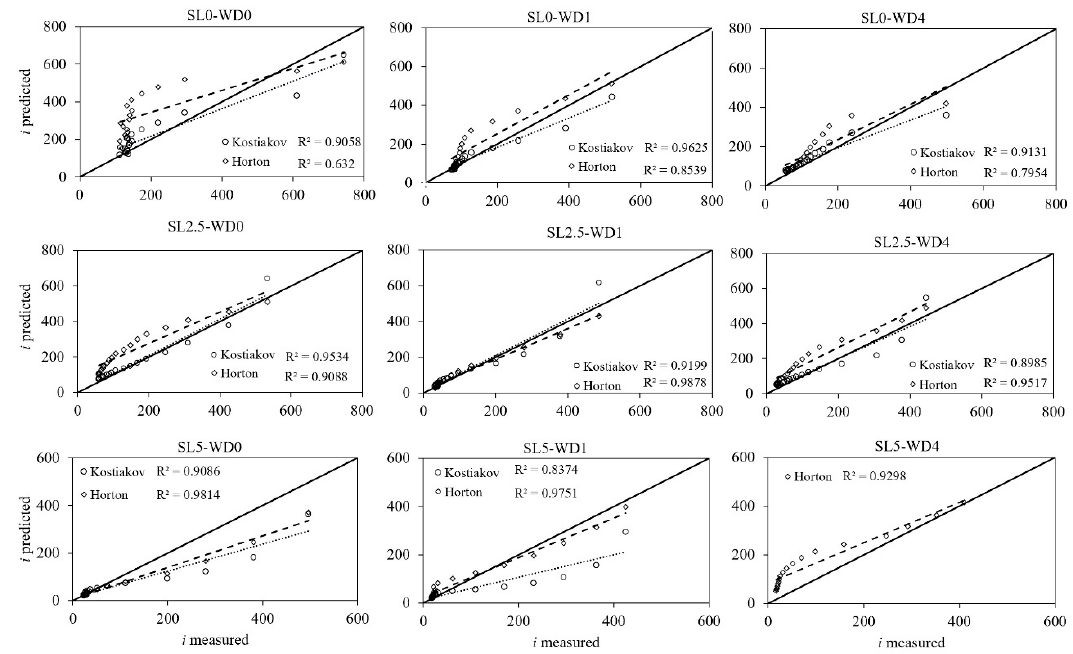
Figure 3. Scatter plot of the observed and predicted infiltration rate i (mm/h) using the Kostiakov, Philip and Horton models for the sandy (S) treatments (S0, S2.5 and S5) for two extreme wetting and drying (WD) cycles WD1 and WD4, compared to WD0. The diagonal represents the line of best fit.